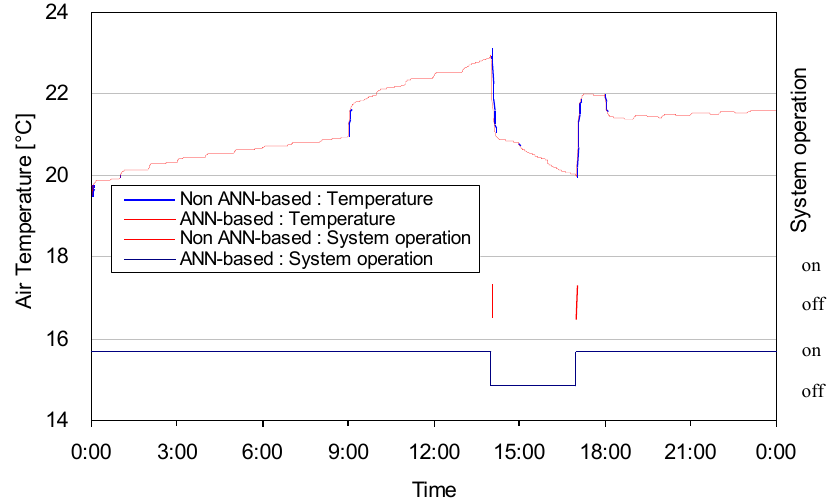
Figure 10. Indoor temperature and operation of heating system (Single skin envelope, 1 January 2013).